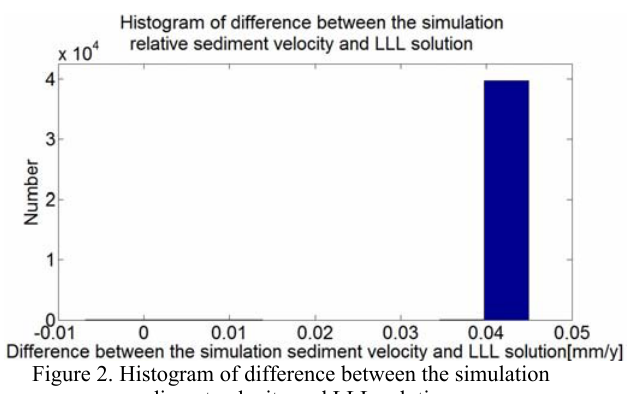
Figure 2. Histogram of difference between the simulation sediment velocity and LLL